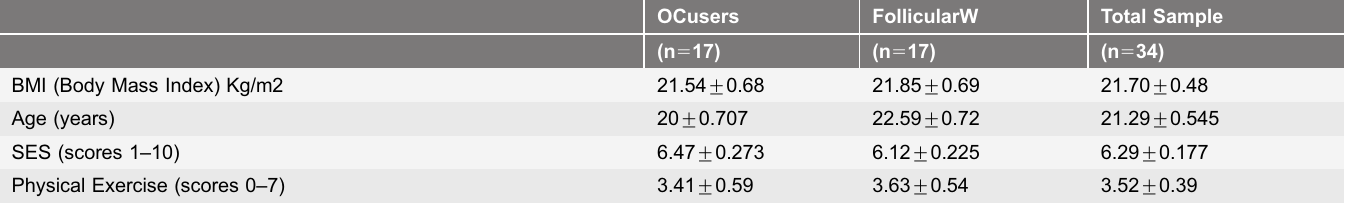
Table 1. Demographic and anthropometric characteristics of total sample and subgroups (Mean scores ¡ SEM) of age, Body Mass Index, Subjective Socioeconomic Status (Subjective SES scale [44]) and physical